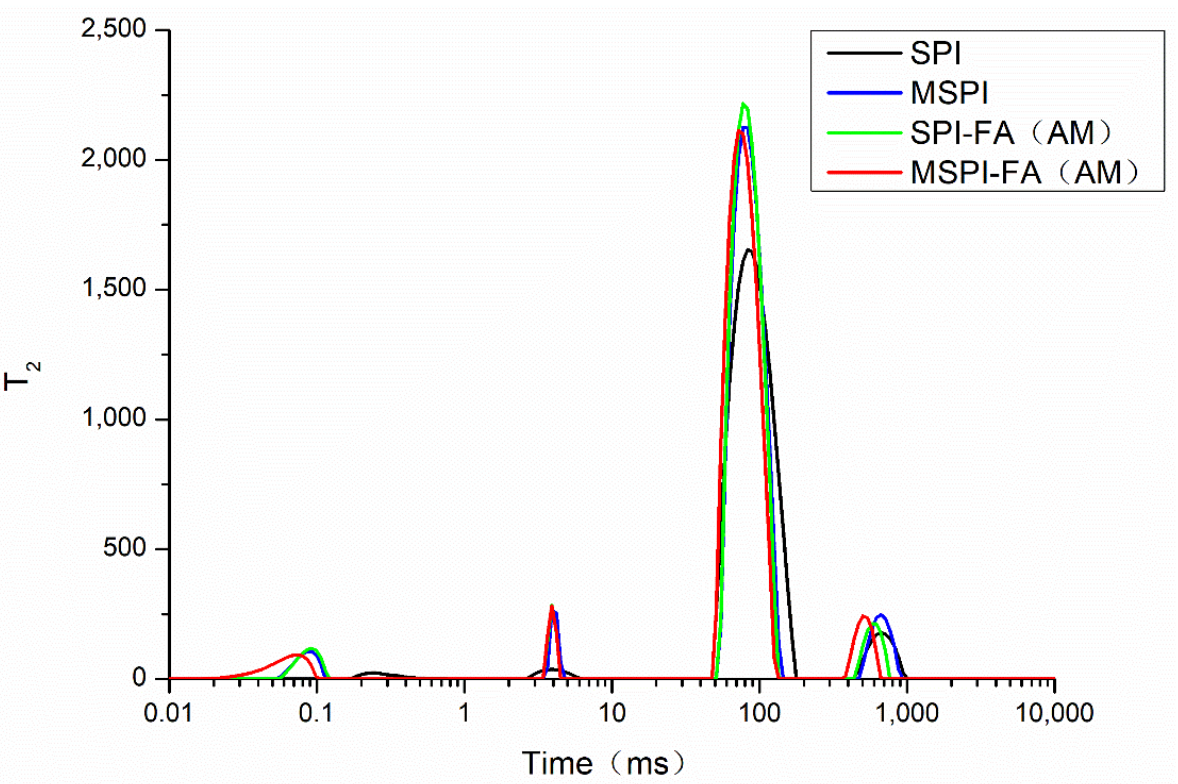
Figure 3. The spin–spin relaxation time (T 2 ) induced by different modified soybean protein isolates. Table 6. Water state of emulsion gels induced by different modified soybean protein isolates.